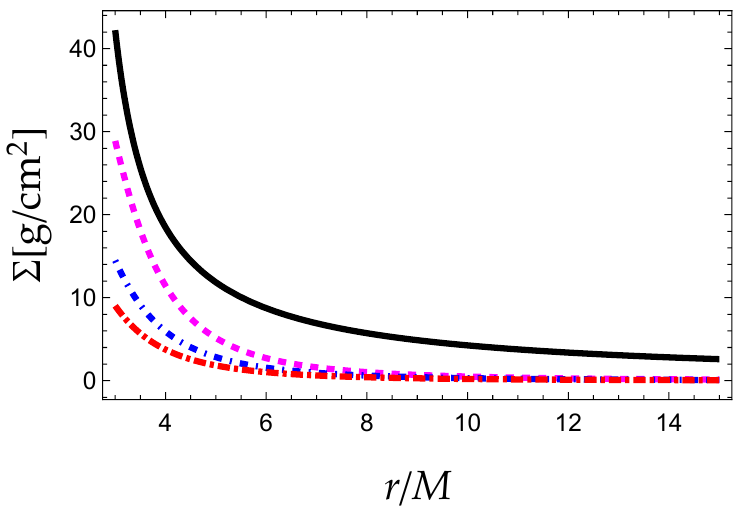
Figure 3. Surface density versus radial coordinate, Σ ( r ) , assuming M = 30 M (cid:12) . The color code is given as follows: m = 0 (solid black line), m = 40 × 10 − 22 GeV (dashed magenta line), m = 50 × 10 − 22 GeV (short-dashed blue line), and m = 60 × 10 − 22 GeV (long-dashed red